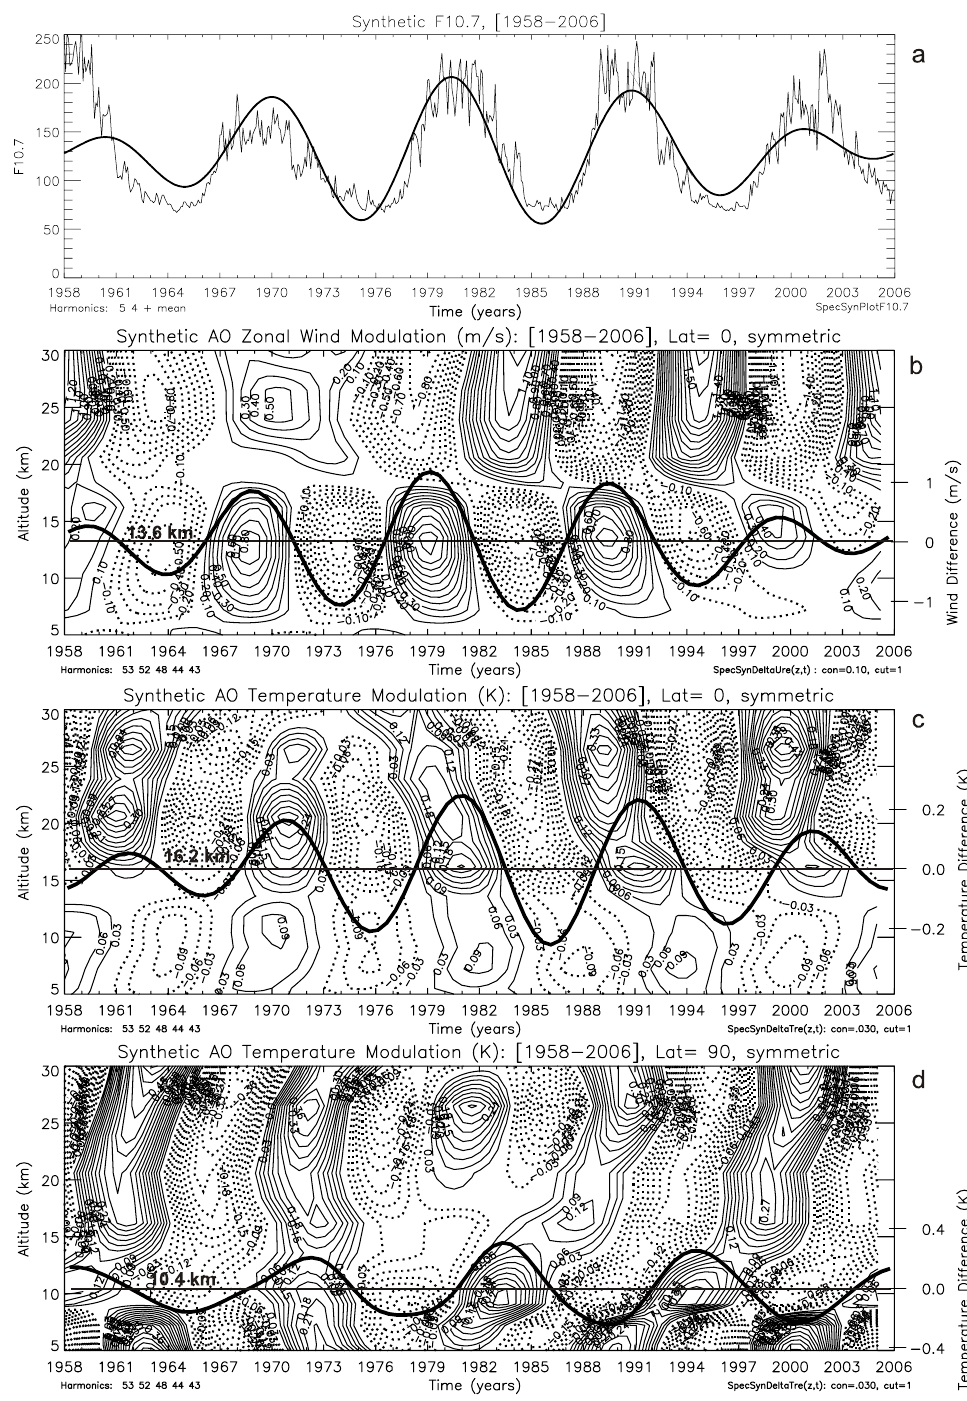
Fig. 7. (a) The monthly 10.7cm flux is shown together with synthesized variations employing h=4 and 5 for the periods of 12 and 9.6 years, respectively. (b) Employing h=48 with h=(48 ± 4) and (48 ± 5), synthesized (filtered) modulations of the zonal winds are presented as contour plot at the equator. With heavy solid line, the modulations are shown at 13.6km where the phase-shifted pattern is similar to that of the synthesized solar flux variation in (a). (c) Analogous to (b) but synthesized temperature modulations at the equator, and with heavy line showing the pattern at 16.2km. (d) Synthesized temperature variations at the pole, and with heavy line at 10.4km. In limited attitude regimes, the filtered equatorial zonal wind (b) and temperature (c, d) modulations of the symmetric AO mimic the solar cycle